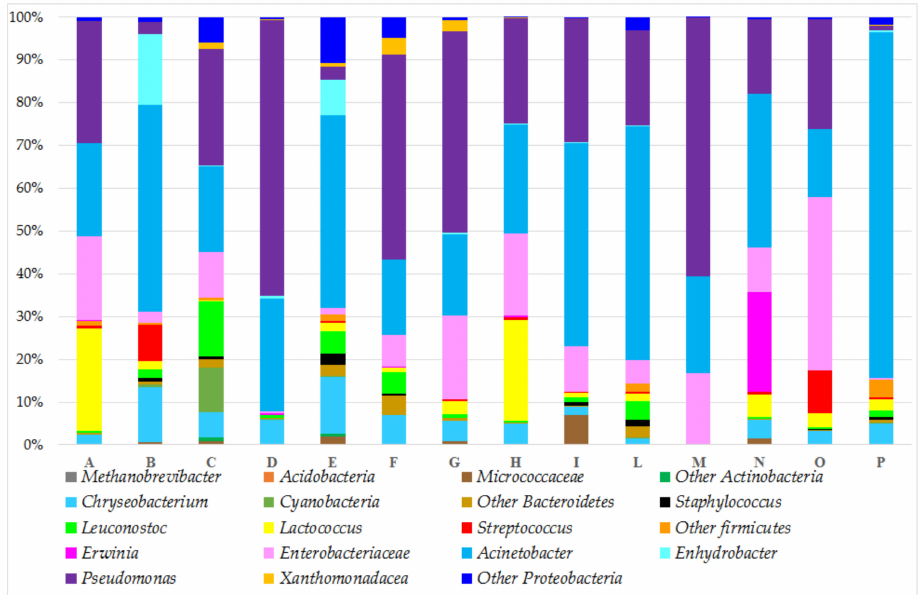
Figure 1. Relative abundances (%) of the main taxa groups (genus level or above) of bacterial sequences from different TMB samples using Illumina MiSeq. Each bar is the mean value of 3 samples collected in different Mfarms located in the Trentino province (for the interpretation of the references to color in this figure legend, the reader is referred to the web version of this